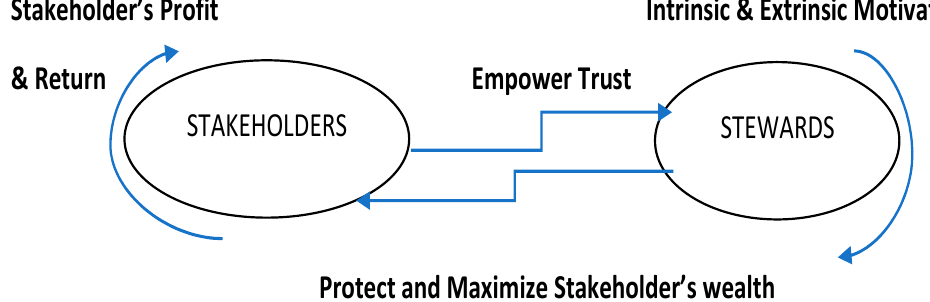
Figure 2. Operational Relation of Stewards and Stakeholders .